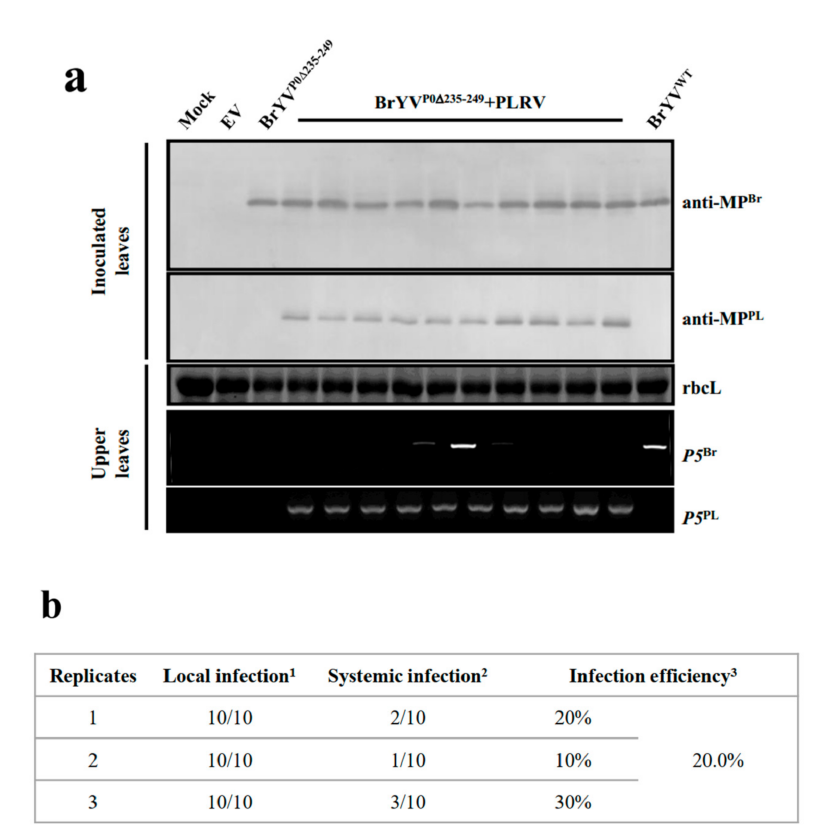
Figure 8. The capability of BrYV mutant BrYV P0 ∆ 235–249 to produce a systemic infection was rescued partially by co-infection with PLRV. ( a ) Protein determinations from virus-inoculated N. benthamiana leaves co-expressed with PLRV at 2 dpi as assessed by Western blotting analysis using a BrYV-MP- specific antibody (anti-MP Br ) and a PLRV-MP-specific antibody (anti-MP PL ). RNA determinations from the upper leaves of N. benthamiana plants at 14 dpi as assessed by RT-PCR. ( b ) Summary of the infection efficiency of BrYV P0 ∆ 235–249 with the help of PLRV. Determination in ( a ) were repeated three times to calculate the BrYV P0 ∆ 235–249 infection efficiency of the inoculated leaves and the systemically infected leaves. 1 The proportion of BrYV P0 ∆ 235–249 detected in the inoculated leaves at 2 dpi. 2 The proportion of BrYV P0 ∆ 235–249 detected in the upper leaves at 14 dpi. 3 The proportion of successful systemic infections by BrYV P0 ∆ 235–249